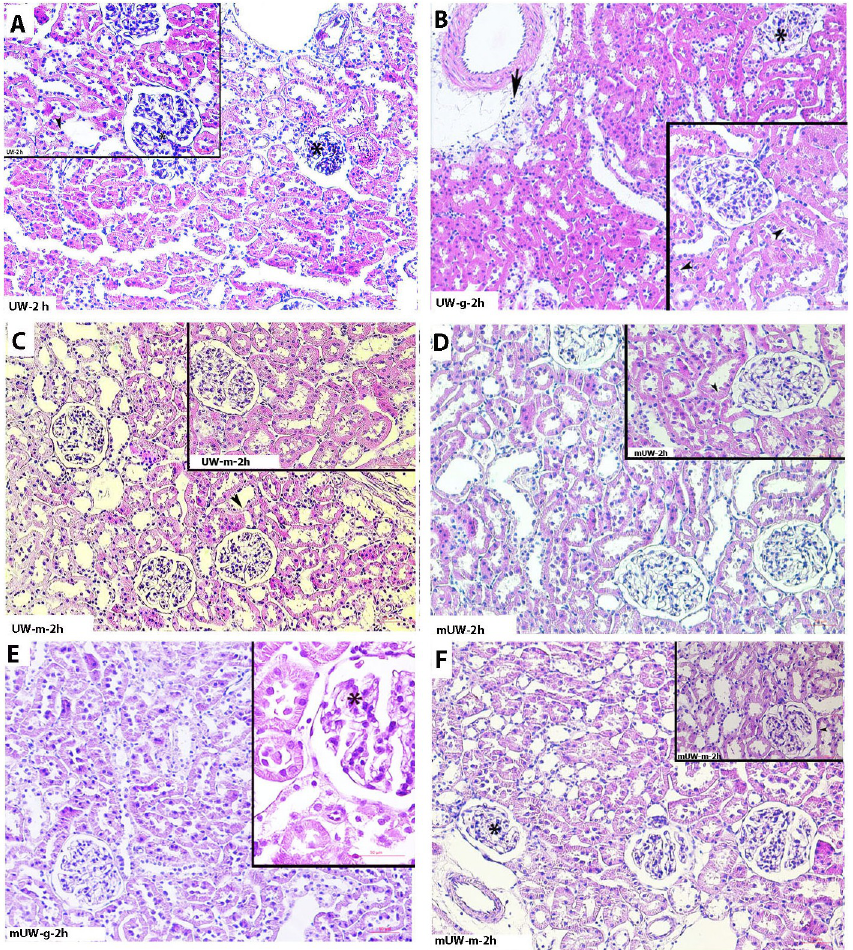
Fig 1. Photomicrographs of kidney tissues stored for 2 hours in experimental kidney preservation solutions. Slight renal tissue degeneration at the 2nd hour of the experimental groups. Glomerular (asterisk) and tubular (arrowhead) degenerations in UW (A ), UW-g (B) , UWm (C) , mUW (D) , mUW-g (E) and mUW-m (F) groups. H&E staining, A, B,C,D,E,F x200 magnification, insets: x400 magnification.